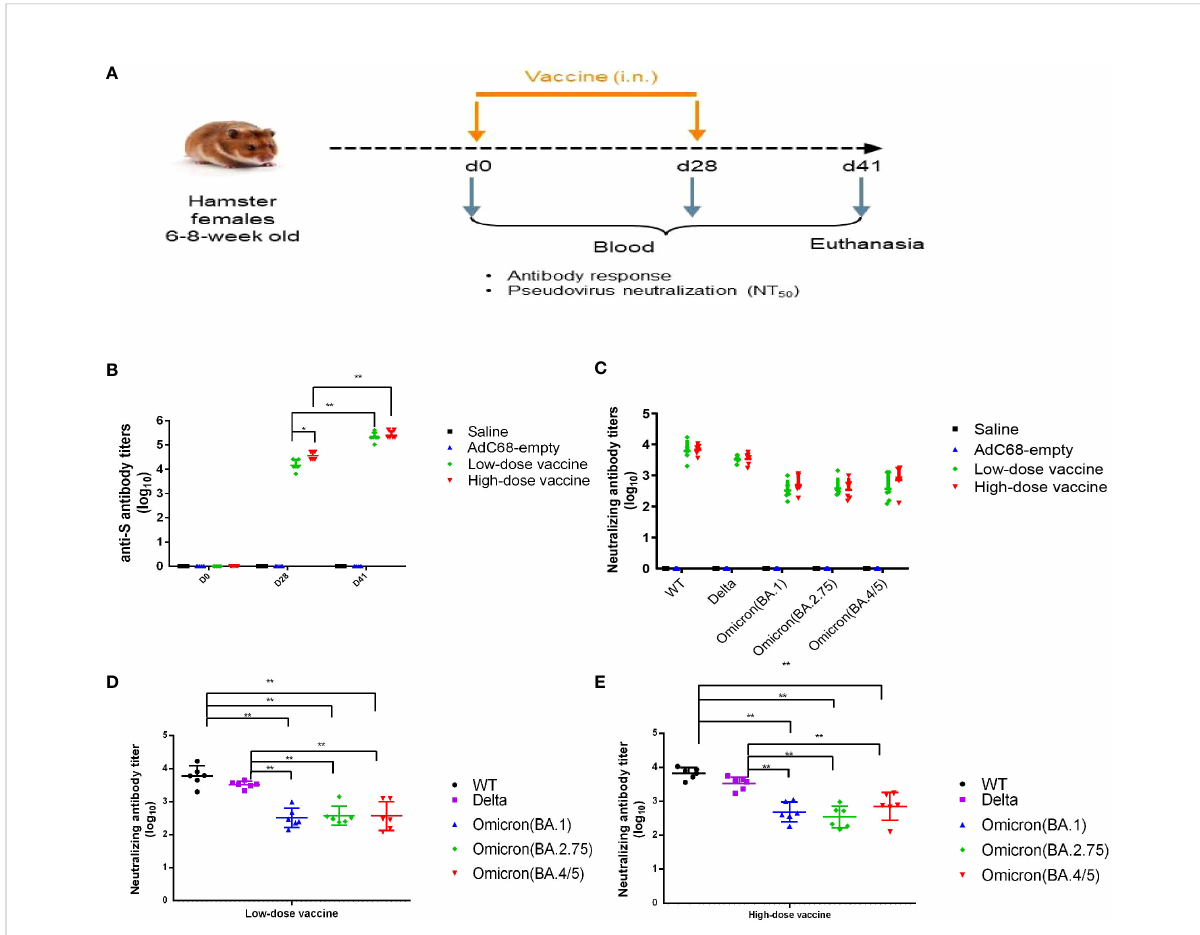
FIGURE 3 Experimental study scheme and cross-neutralizing antibody titers. (A) Schedule of vaccine administration. (B) Binding anti-spike IgG antibody titers in golden Syrian hamsters ’ sera. (C – E) Cross-neutralizing antibody titers in golden Syrian hamsters ’ sera. * p < 0.05, ** p <